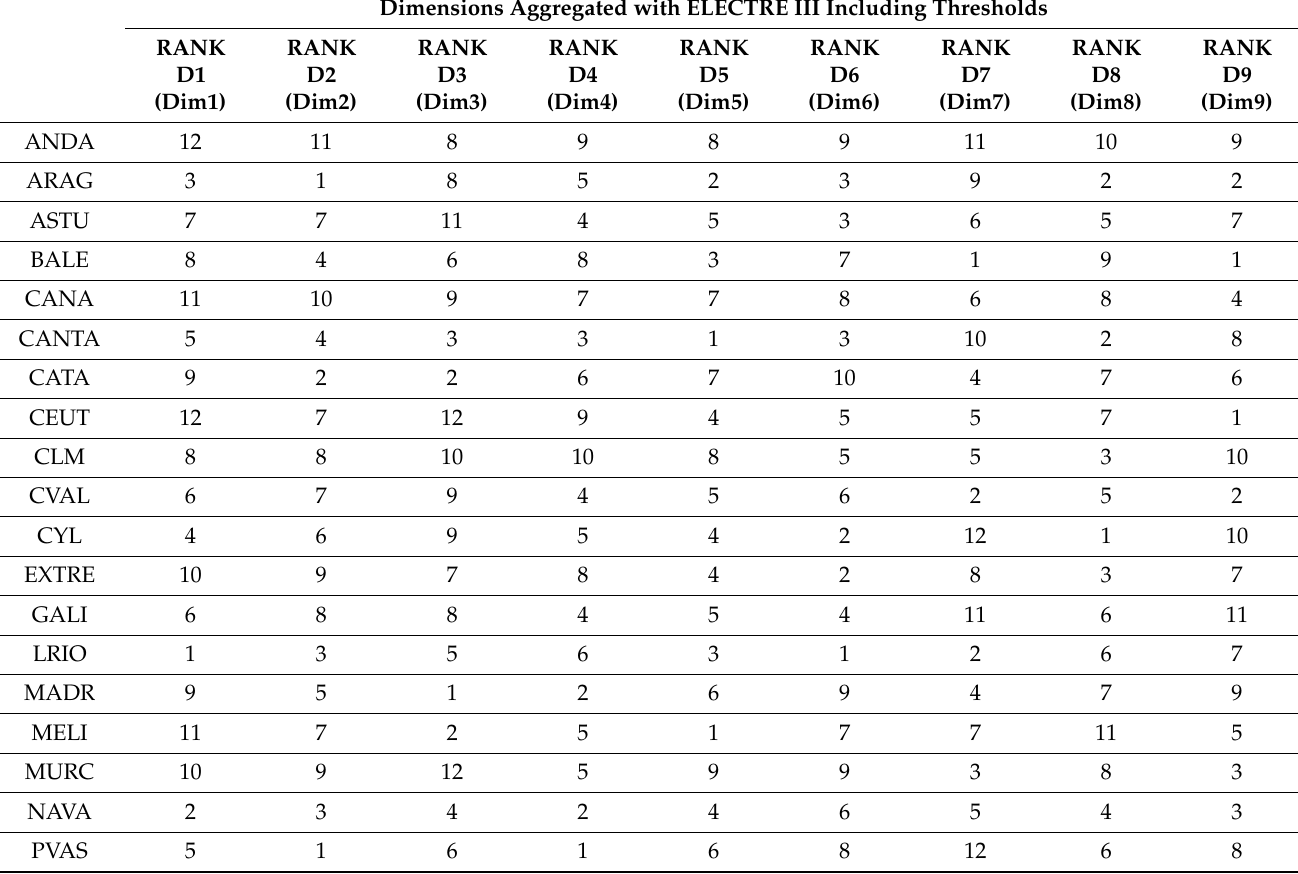
Table 9. The 9 dimensions obtained aggregated with ELECTRE III including